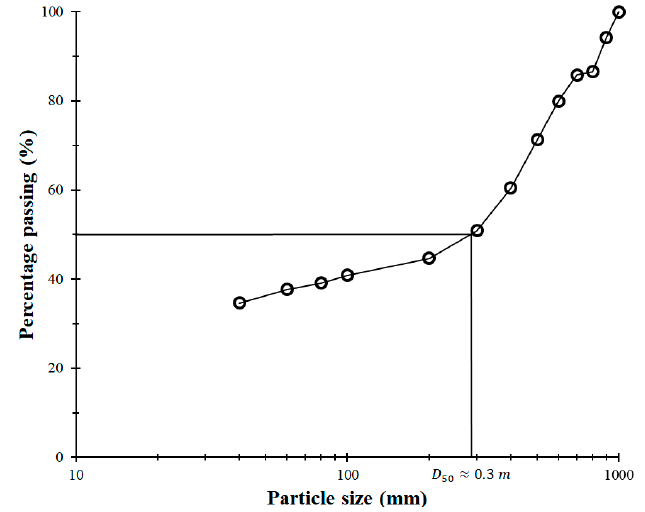
Figure 4. Particle size distribution of the soil sample from image digitalization.